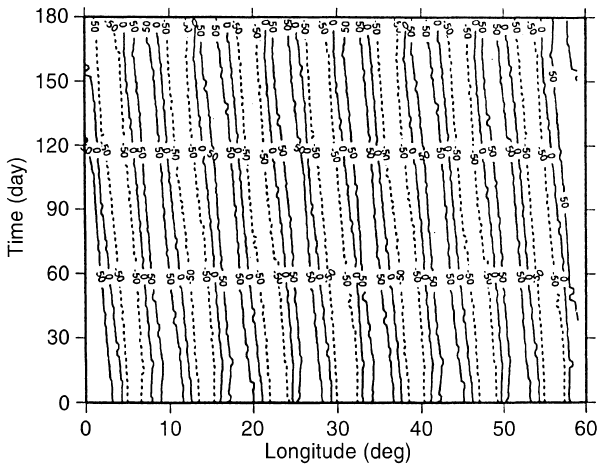
Fig. 10. Annual-Rossby-wave-like alias propagation of a harmonic signal with a unit amplitude and a period of 16.29 days observed under the Geosat sampling scheme. The contours have been multiplied by 100 and the interval is 50. Solid and dashed lines denote positive and negative values,